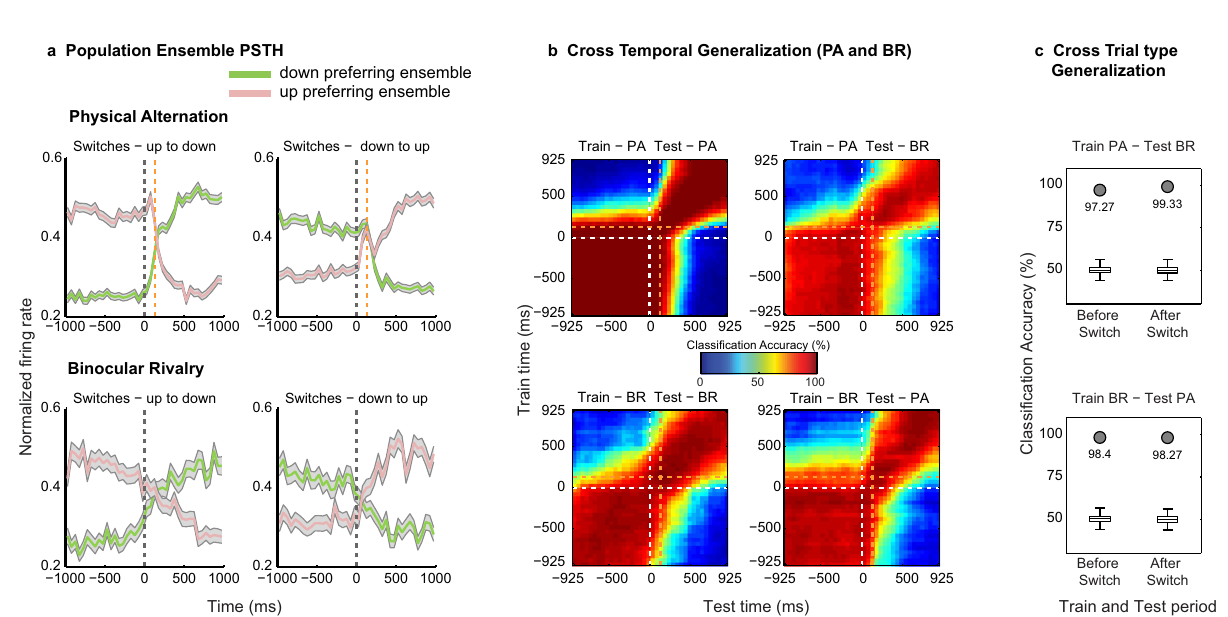
Fig. 2 Sensory (PA) versus perceptual (BR) modulation of spiking activity - d ’ and average population activity. a , Scatter plot of sensory vs. perceptual selectivity (d ′ ) for all units (dots) during BFS and BR. Displayed with different colors are units; showing no signi fi cant modulation in PA or BR trials (grey); those with signi fi cant modulation for the same stimulus during both trial types (green); units displaying signi fi cant preference only during PA (red) and units displaying signi fi cant modulation only during BR trials (blue) and a small percentage of units which fi red more when their preferred stimulus was perceptually suppressed (cyan). Proportion of perceptually modulated units for both BFS and BR increased as a function of sensory selectivity strength (insets showing perceptual modulation for d ’ >1, BFS - 90% and BR - 86%). b , Population activity averaged across units, which were signi fi cantly modulated during PA (upper row, presented in black) or BR (lower row, presented in red) trials and preferred the same stimulus, is plotted for perceptual dominance brought about by BFS (left) or during BR (middle), as well as switches (right) during BR. Plotted above is population activity during temporally matched phases in PA. Shaded regions depict standard error of the mean. The orange dashed line indicates the average delay between the physical stimulus transition and the OKN derived transition during PA trials (129.4 ± 36.6 ms following the onset of change in the physical stimulus). A remarkable similarity in population activity across trial types indicates robust perceptual modulation. Source data are provided as a Source Data fi le.